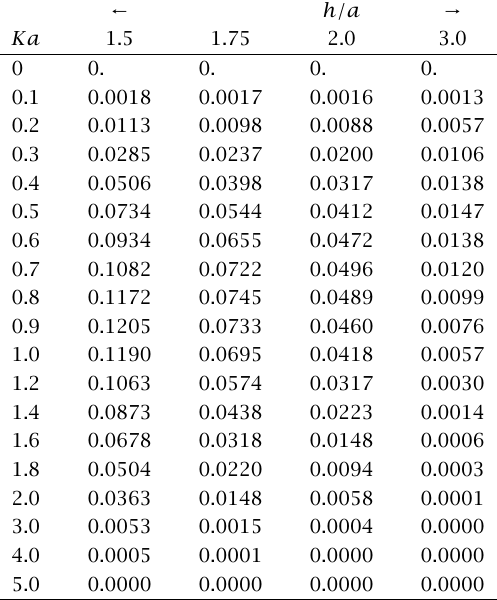
Table 7.2 . Surge damping coefficients λ 11 for different submergence (h/a)